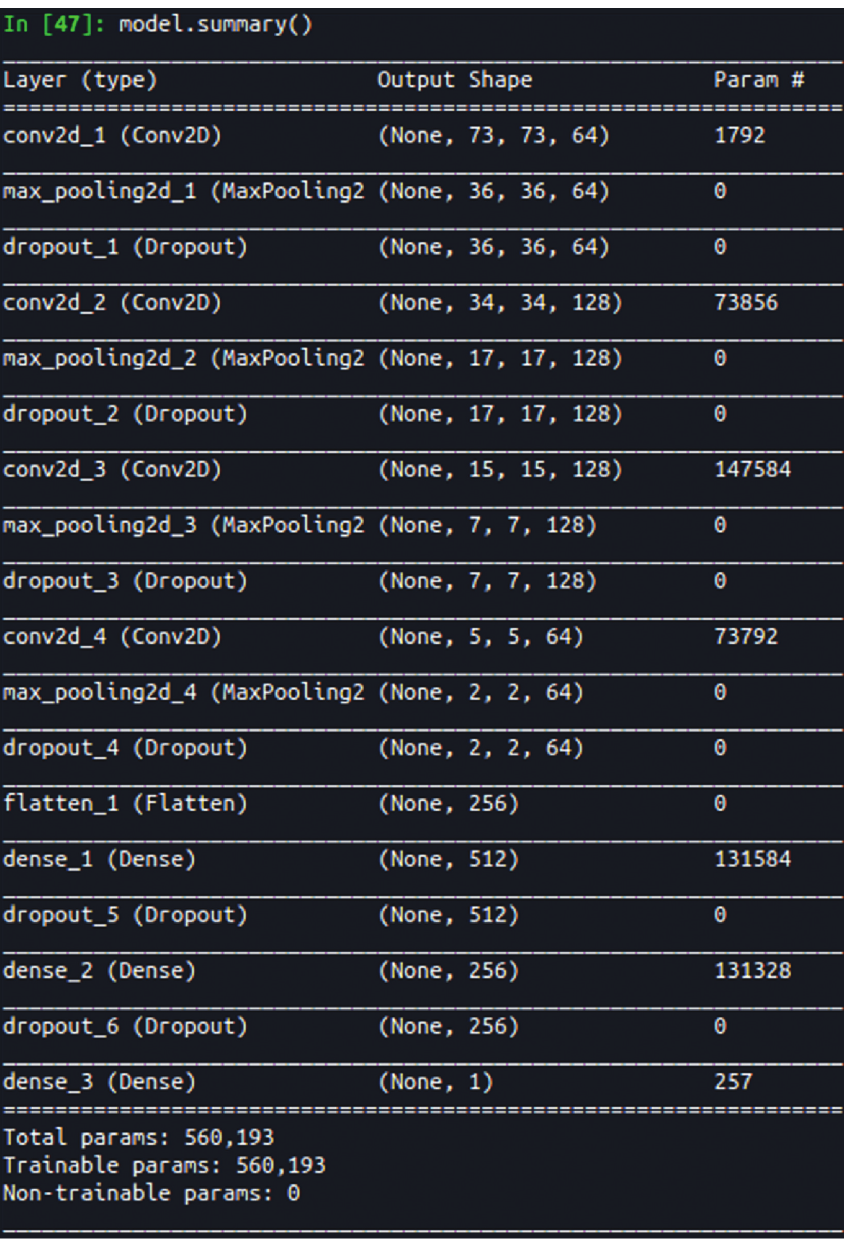
Figure 3: CNN Model